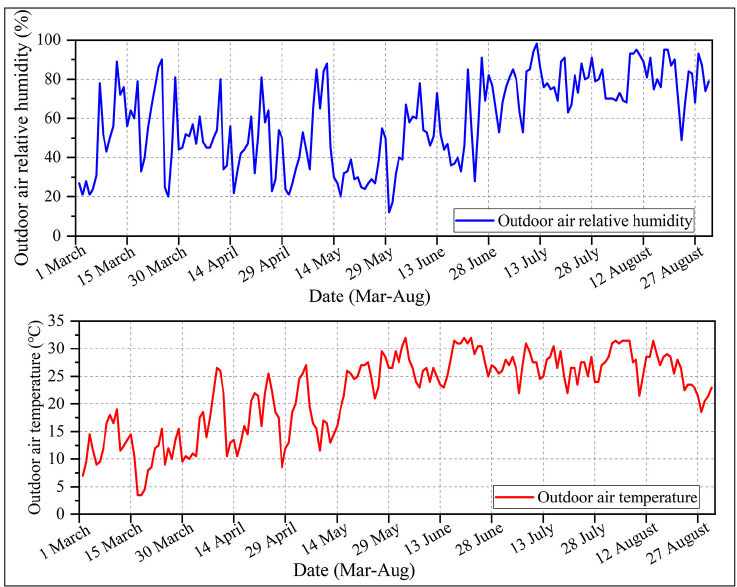
Figure 2. Outdoor weather data acquired during the experimental period from 1 March to 31 August